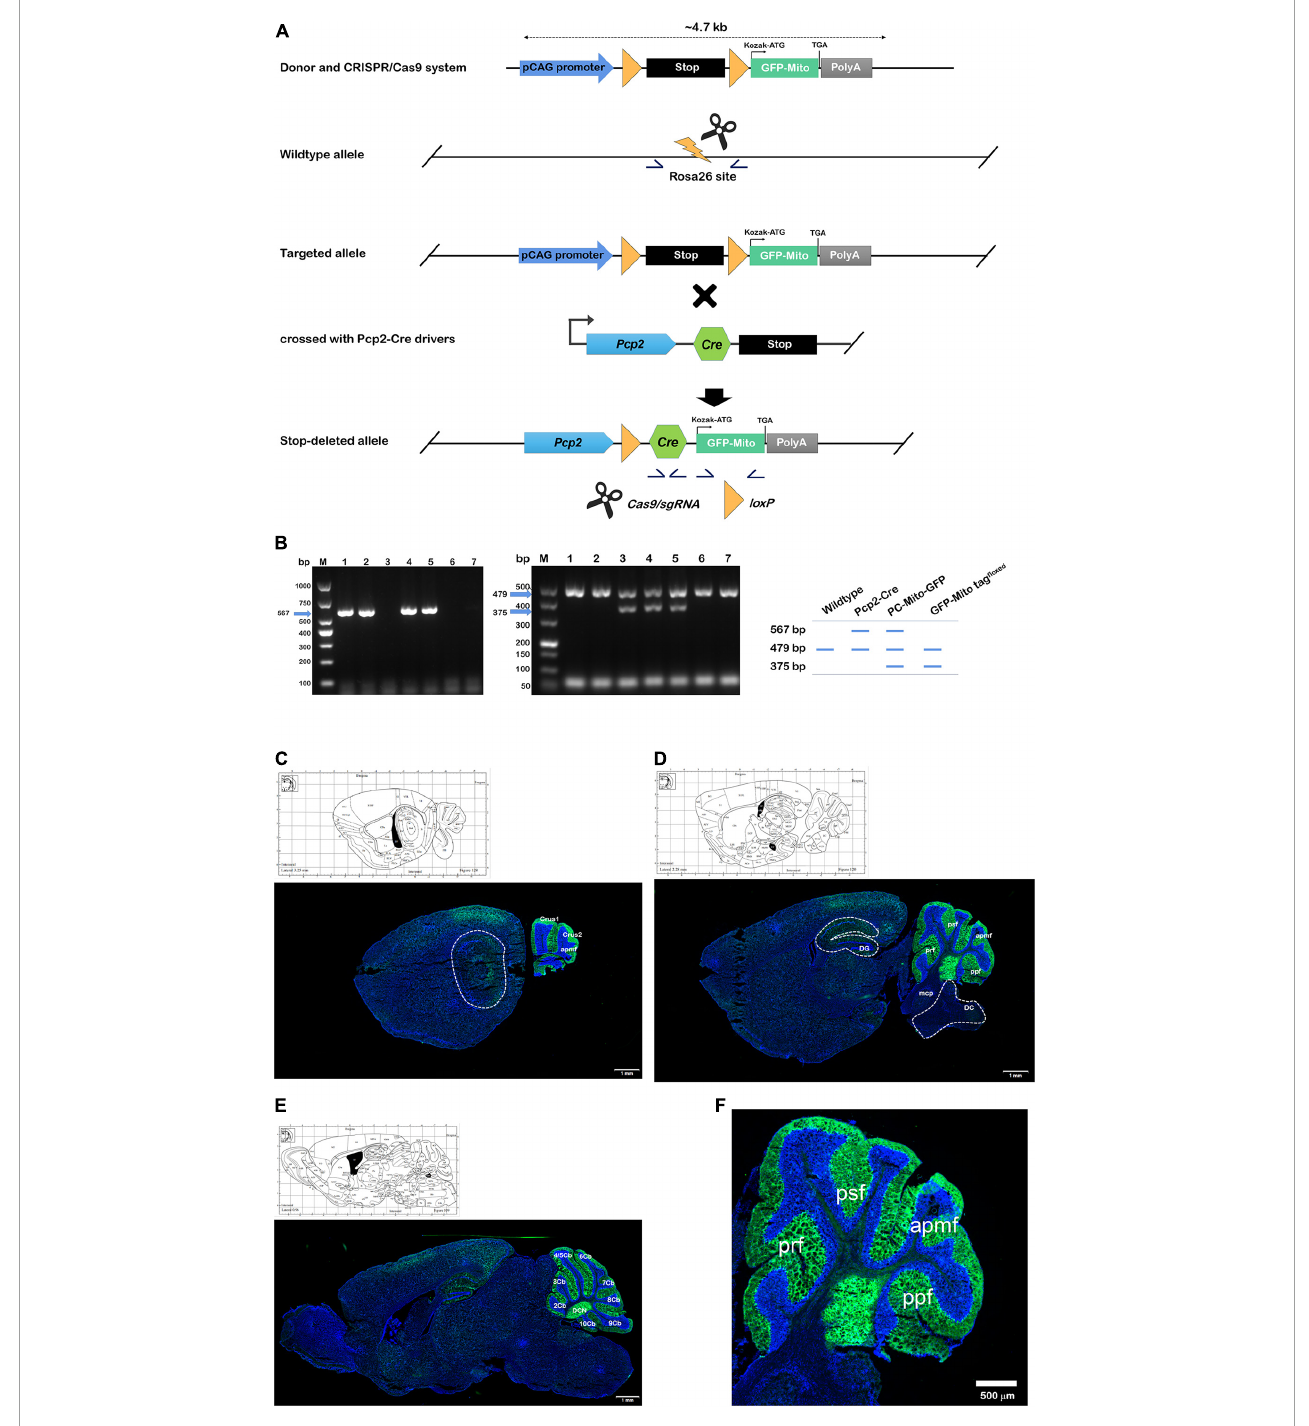
FIGURE1 Construction of GFP-Mito tag floxed and PCs-Mito-GFP mouse lines. (A) Design and generation of PCs-Mito-GFP mice by using CRISPR/Cas9 system. Homologous recombination of the targeting construct in embryonic stem cells results in insertion of the Cre-dependent mito-GFP cassette into the Rosa26 locus. Then targeting of mito-GFP into the Rosa26 locus. In targeted allele mice, removal of the neomycin selection marker by Flp recombinase results in the PCs-Mito-GFP line, which can be mated to a Cre driver line to obtain cell-specific labeling of mitochondria. Germline excision of the termination signal produces the PCs-Mito-GFP line. Yellow arrowheads, loxP sites; stop symbol, termination cassette; gray diamonds, frt sites; half arrows, PCR primers for genotyping; short horizontal line, probe for Southern blot. (B) PCR genotyping of the wildtype, Pcp2-Cre, Pcp2-Mito-GFP and GFP-Mito tagfloxed strain using the three primers in schematic. (C–E) The internal image at lateral 3.25 mm (C) , 2.28 mm (D) , and 0.96 mm (E) according to Allen map (http://mouse.brain-map.org/static/atlas). All mitochondria within the PCs in Crus 1, Crus 2, apmf, prf, psf, ppf, as well as 2 ∼ 10 Cb of cerebellar cortex expressed bright green fluorescence under a Zeiss confocal microscope equipped with Airyscan 2 system, while all other mitochondria all over the brain and cerebellum had no fluorescence. 2 ∼ 10 Cb; the 2nd ∼ 10th cerebellar lobule; apmf, ansoparamedian fissure; Cop, copula of the pyramis; CPu, caudate putamen (striatum); Crus 1/2, crus 1/2 of the ansiform lobule; DC, dorsal cochlear nucleus; DCN, deep cerebellar nucleus; DG, dentate gyrus; mcp, middle cerebellar peduncle; PM, paramedian lobule; ppf, prepyramidal fissure; prf, primary fissure; psf, posterior superior fissure; Sim, simple lobule. Bars in panels (C–E) = 1 mm. (F) Enlarged version of image d within the cerebellum. Bar = 500 µ